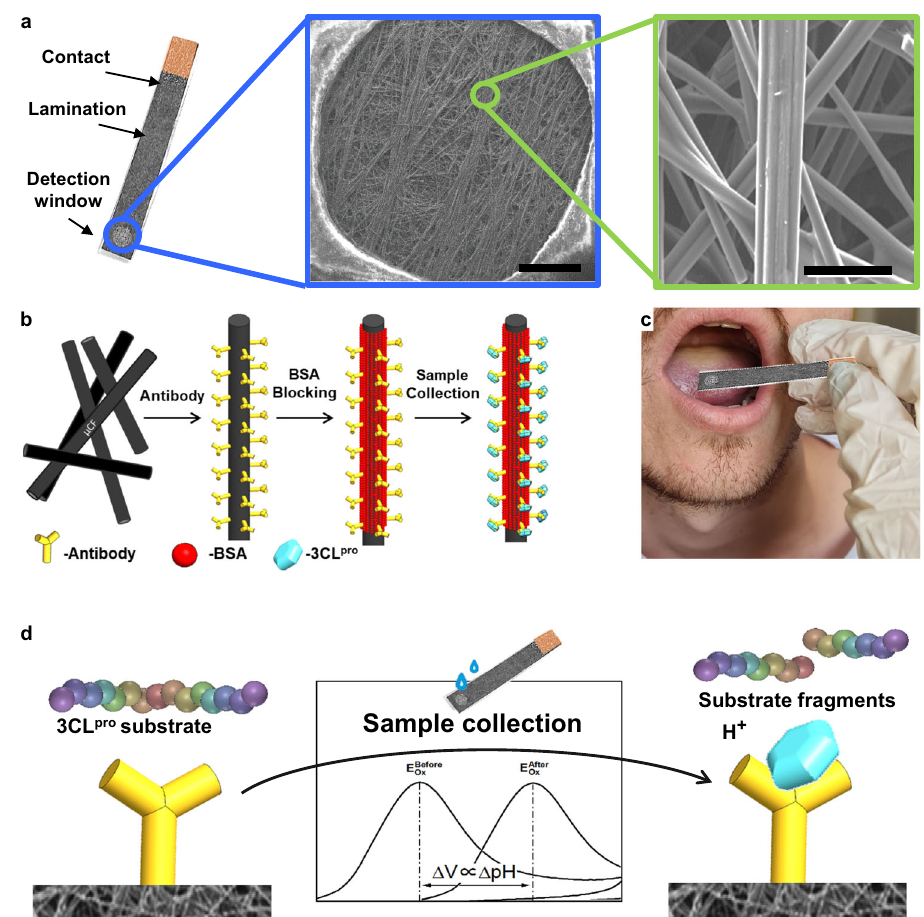
Fig. 1 | CPEsurface, immuno-functionalization, and biosensormethod. a Photo of CPE. Blue inset: SEM images of the detection window, scale bar: 1mm. Green inset: SEM images of 3D micro fi ber matrix of CPE,scale bar: 50 μ m. b Schematic of